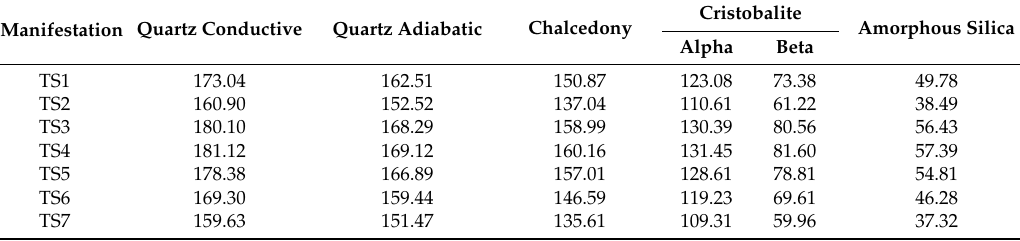
Table 4. The result of silica geothermometer calculation based on various types of silica minerals. The red box is a reference geothermometer type for the research area. Manifestation Quartz Conductive Quartz Adiabatic Chalcedony